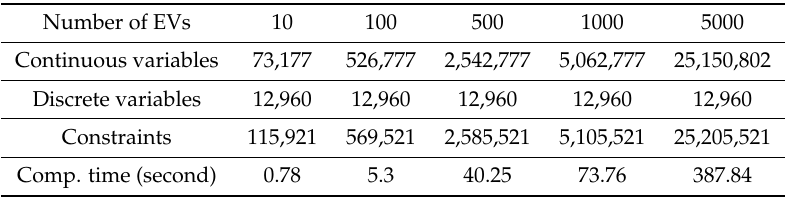
Table 3. Model statistics for different